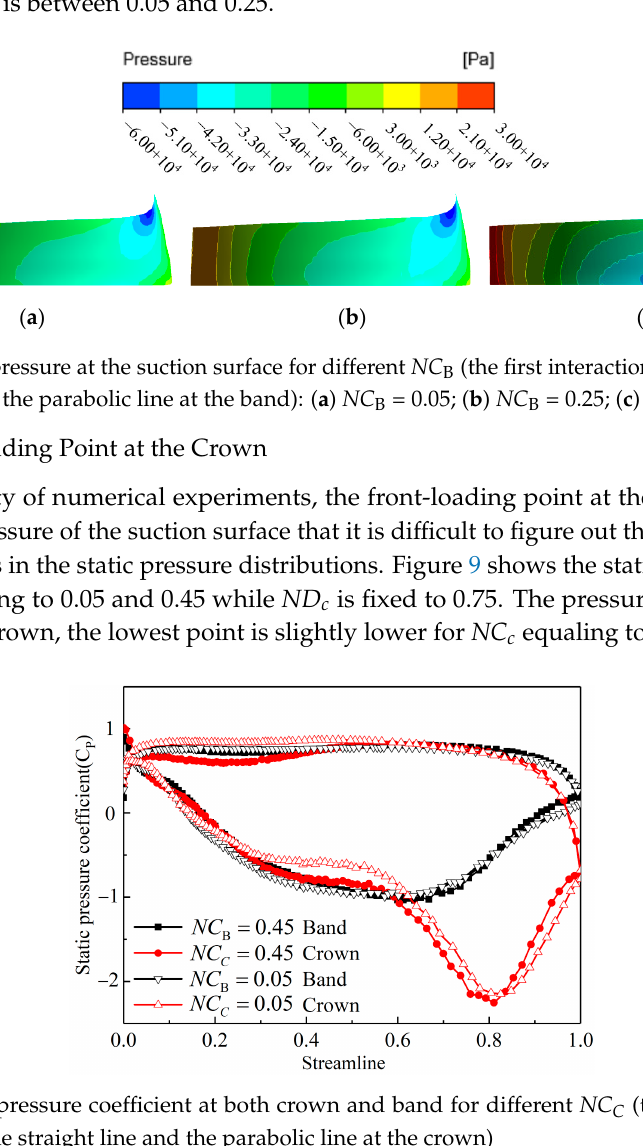
Figure 7. Velocity distributions at the runner outlet: ( a ) ND B is between 0.55 and 0.75; ( b ) ND B is between 0.75 and 0.95.